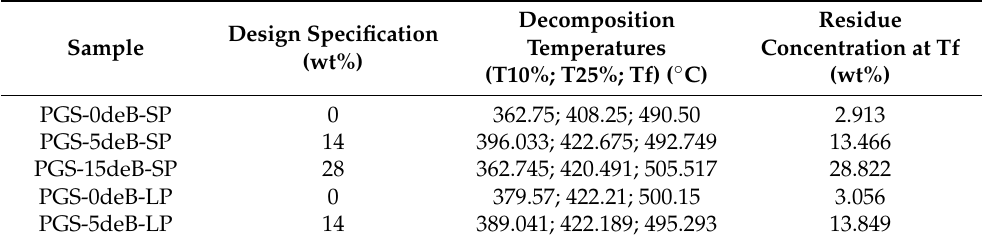
Table 1. Concentration of decellularized bone (deB) in the PGS/deB blend scaffolds, and the decom- position temperatures (Tx and Tf).